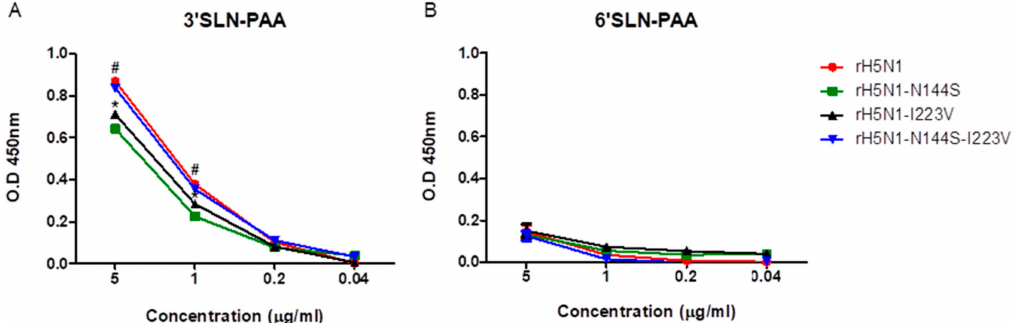
Figure 3. Receptor binding a ffi nity of recombinant H5N1 viruses. The two types of serially diluted biotinylated sialylglycopolymers (Neu5Ac α 2-3Galb1-4GlcNAcb–PAA-biotin (3 (cid:48) SLN–PAA) and Neu5Ac α 2-6GalNAca–PAA-biotin (6 (cid:48) SLN–PAA)) were incubated with the same concentration (10 5 EID 50 ) of recombinant viruses. After development with horseradish peroxidase (HRP)-conjugated streptavidin and 3,3’5,5’-Tetramethylbenzidine (TMB) substrate, the reaction was stopped by adding stop solution, and the absorbance at 450 nm was measured. ( a ) Receptor binding a ffi nity of recombinant viruses to 3 (cid:48) SLN–PAA and ( b ) Receptor binding a ffi nity of recombinant viruses to 6 (cid:48) SLN–PAA. The absorbance data are the average of three independent experiments, # significant di ff erence of rH5N1 and rH5N1-N144S-I223V compared to the other viruses, * significant di ff erence compare to rH5N1–N144S ( p <